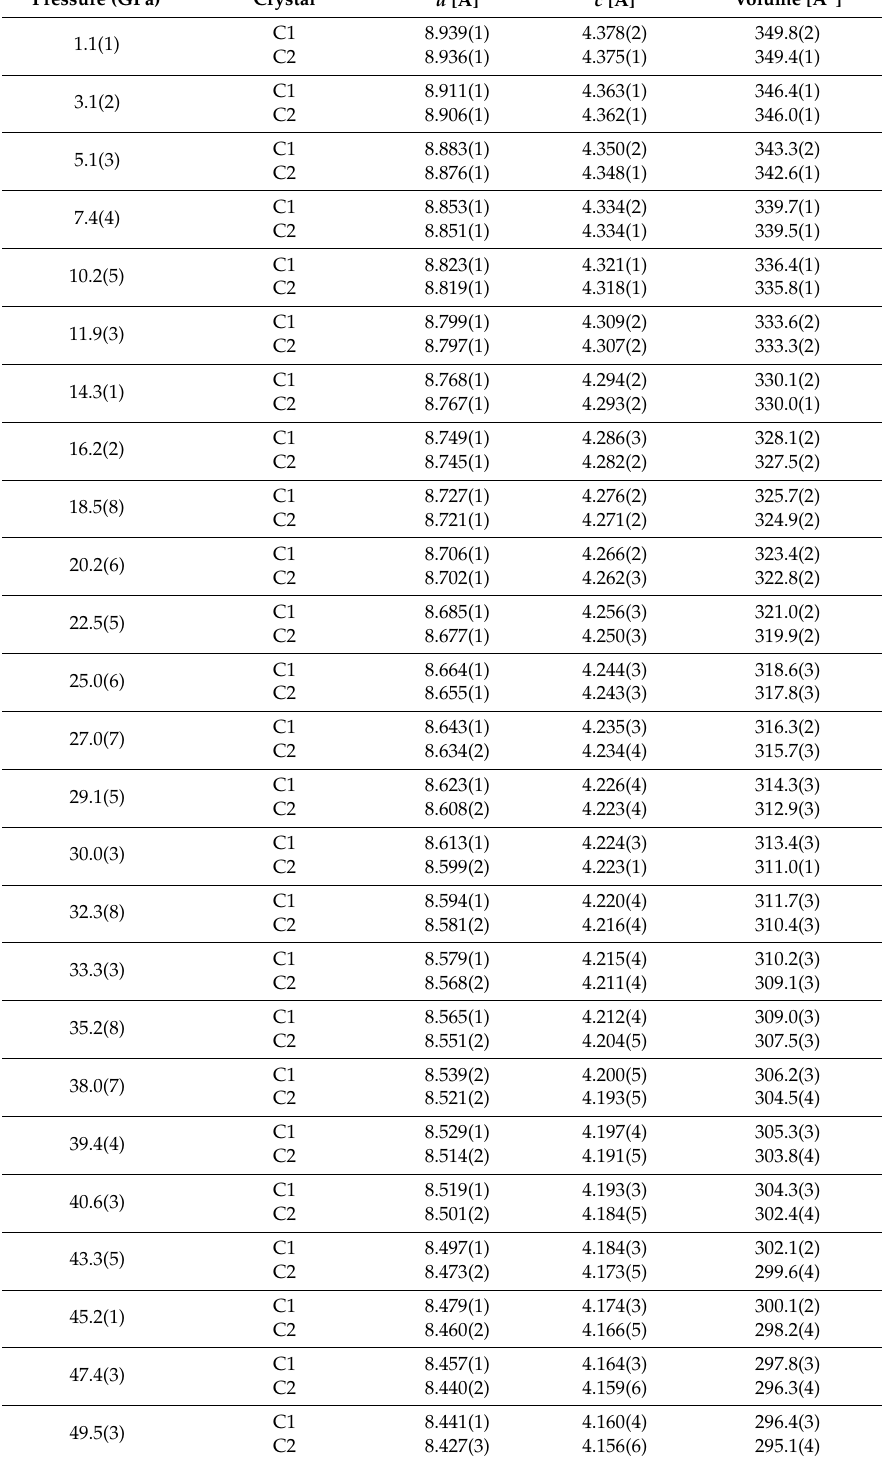
Pressure dependence of the unit cell parameters of Ni 3 P determined in the single crystal